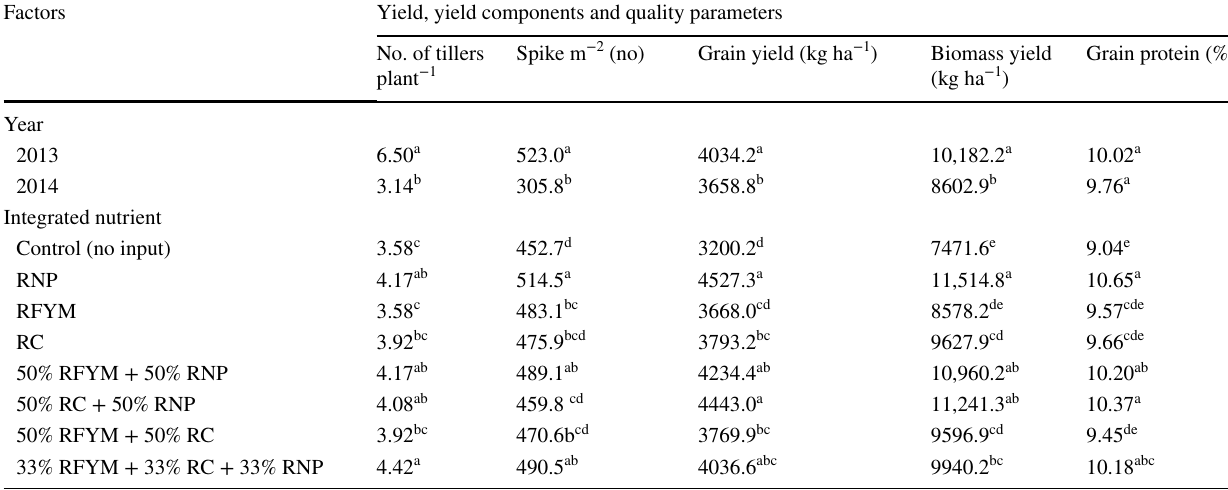
Table 6 Table of means for the effect of treatments on yield, yield components and grain quality of malting barley at Lemu-Bilbilo district in southeastern Ethiopian highlands Yield, yield components and quality parameters